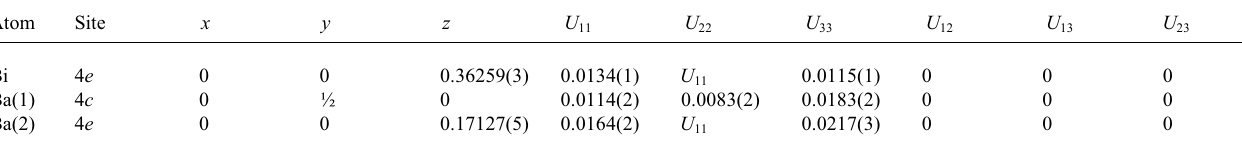
Table 6. Atomic coordinates and displacement parameters (in Å 2 ).